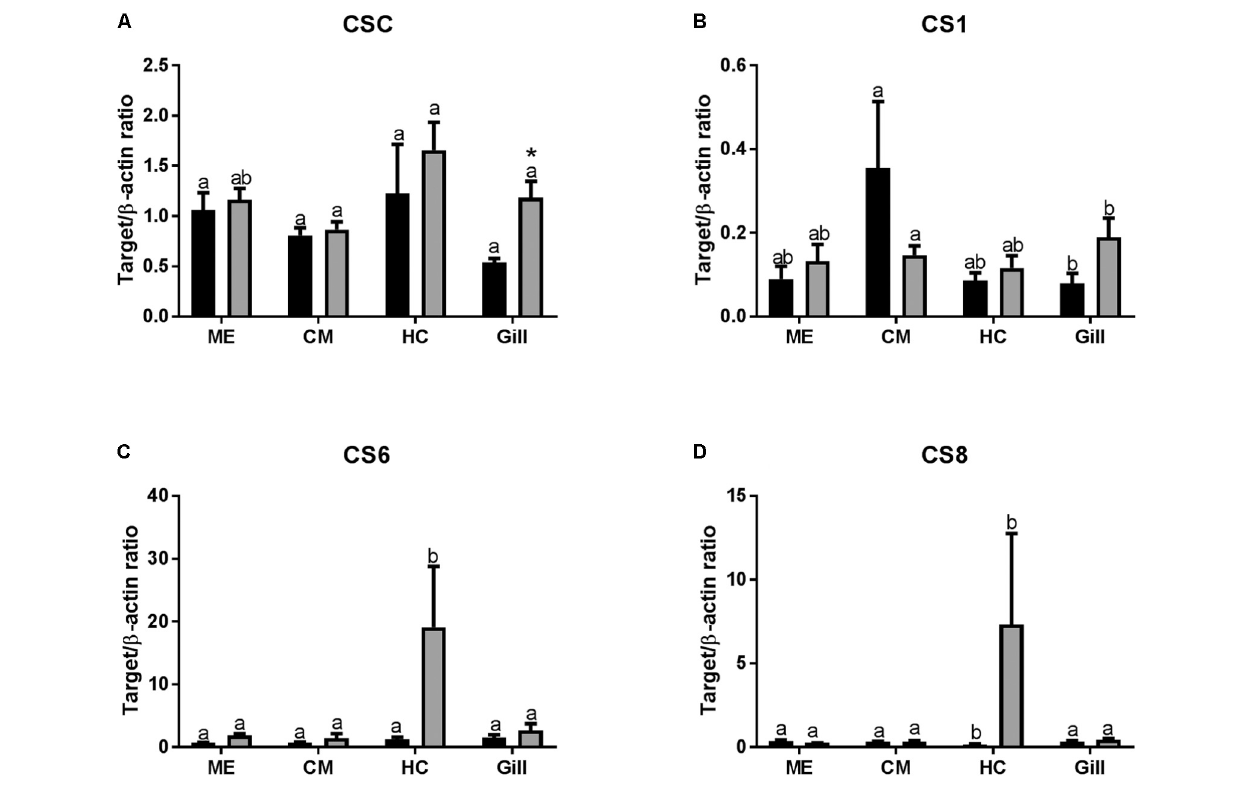
FIGURE 5 | Levels of mRNA expression of chitin synthases in tissues of adult C. gigas in response to a 2-week axitinib exposure. Genes: (A–D) CSC, CS1, CS6, and CS8 – chitin synthases C, 1, 6, and 8, respectively. Control – control oysters and Inh – axitinib-exposed oysters. Expression levels in the mantle edge (ME), central mantle (CM), hemocytes (HC), and the gills (Gill) are shown Different letters indicate significant differences between different tissues under the same treatment conditions (i.e., control or axitinib exposure); columns that do not share a letter are significantly different ( p < 0.05). Asterisks indicate significant differences between the control and axitinib-exposed oysters in the same tissue. N =